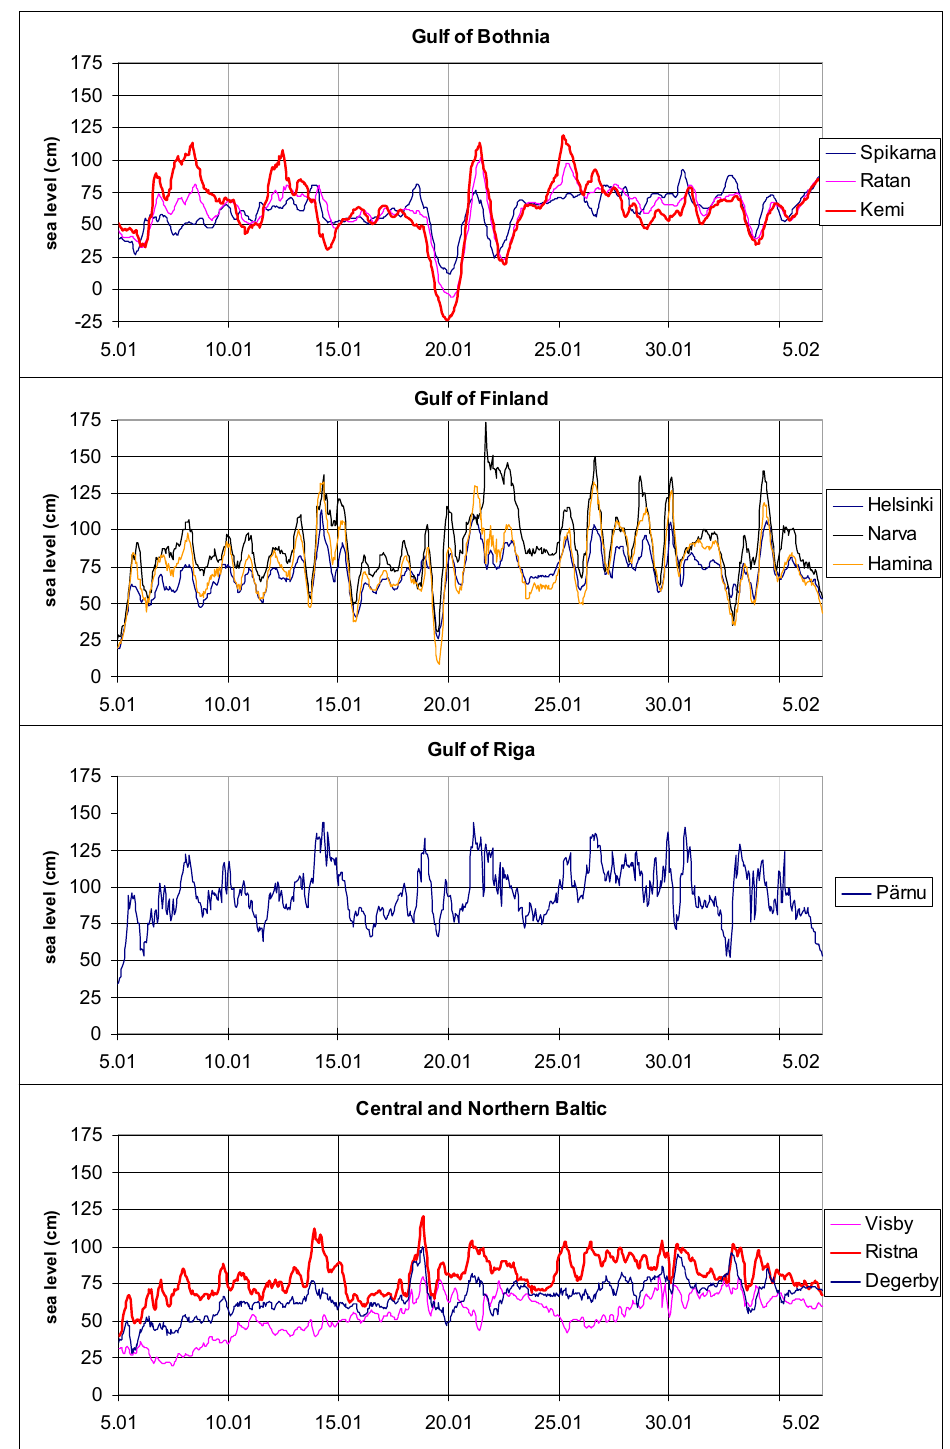
Figure 11. Example of filling the Baltic Sea sub-basins between 5 January and 5 February 1983. Sustained high sea levels result from prolonged western circulation and a significant influx of waters from the North Sea. The above analyses indicated the existence of a clear process of increasing duration of high sea level, increase in storm surge frequency, and increase in height of maximum